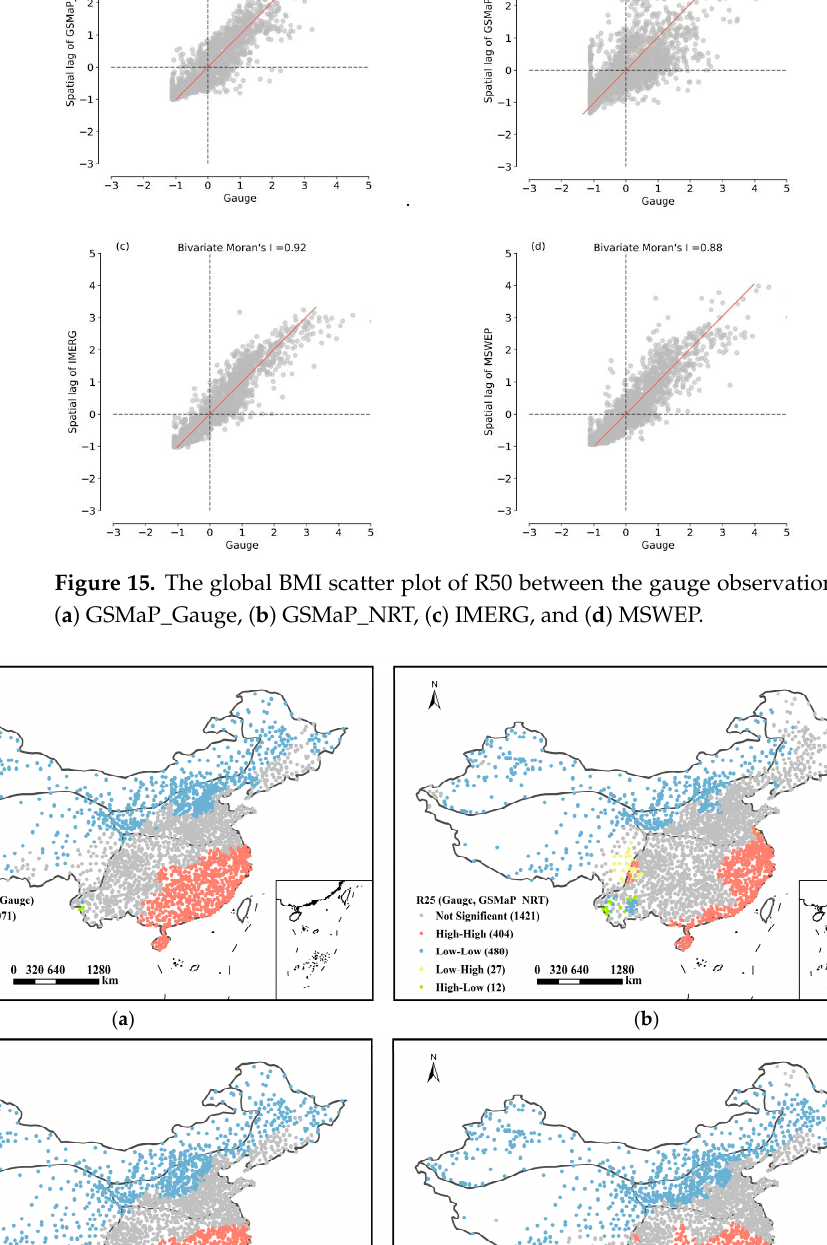
Figure 15. The global BMI sca tt er plot of R50 between the gauge observations and the four SPPs: ( a ) GSMaP_Gauge, ( b ) GSMaP_NRT, ( c ) IMERG, and ( d ) MSWEP.